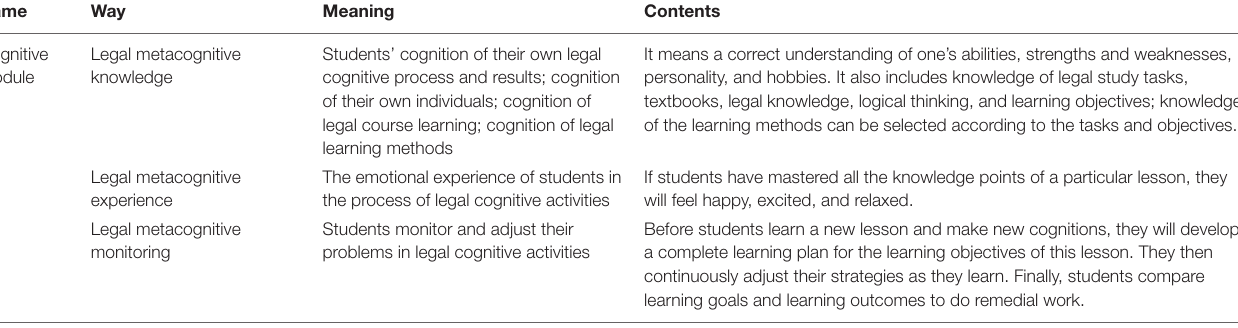
TABLE 3 | Contents of cognitive modules.